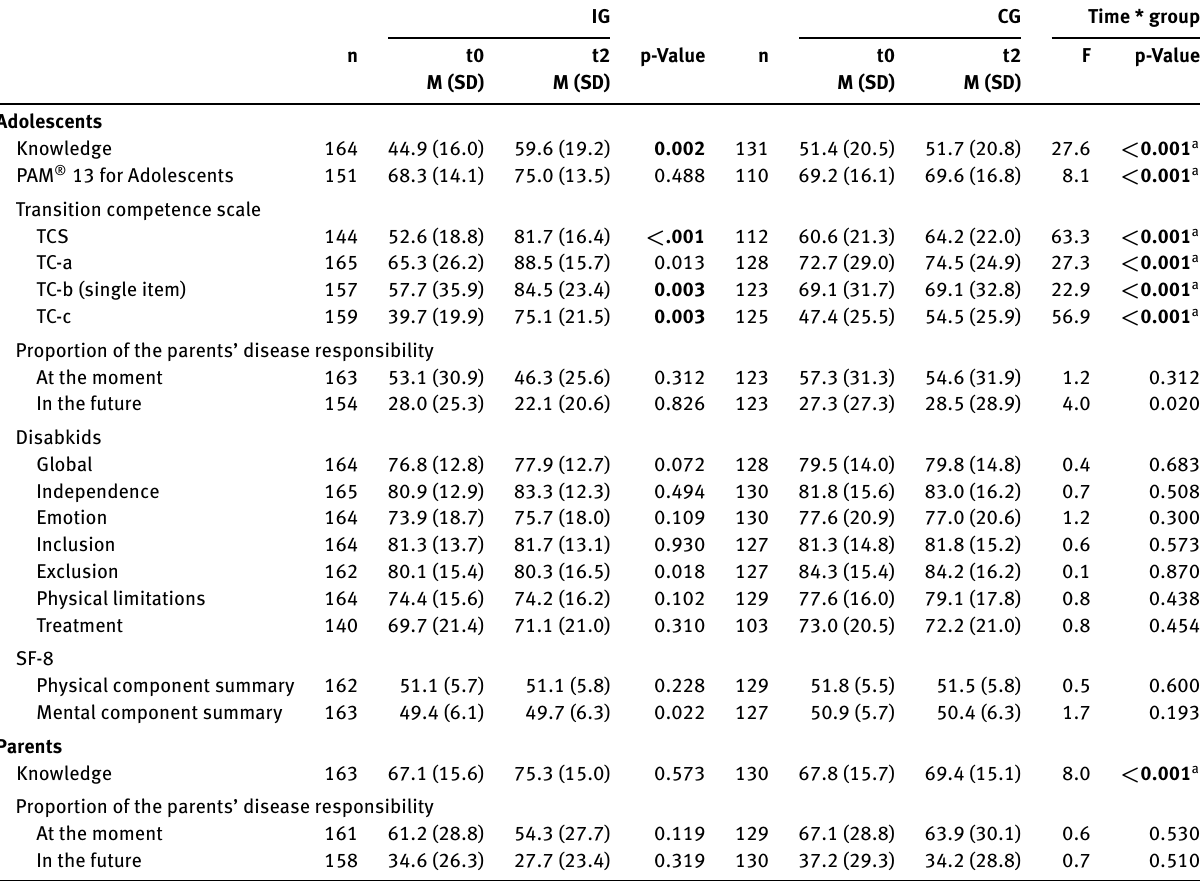
Table 3: Outcome changes from pre-intervention to 4 weeks follow-up by intervention group (IG) and control group